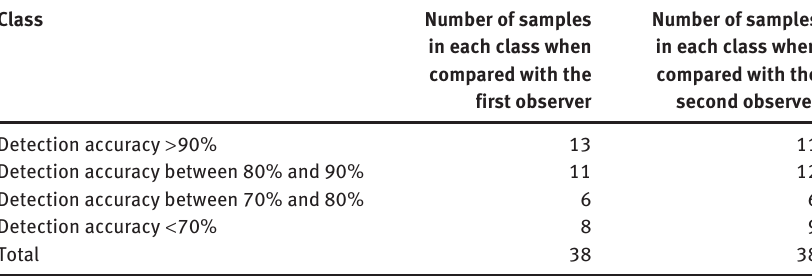
Table 2. Individual Result of Detection Grouped into Four Classes.